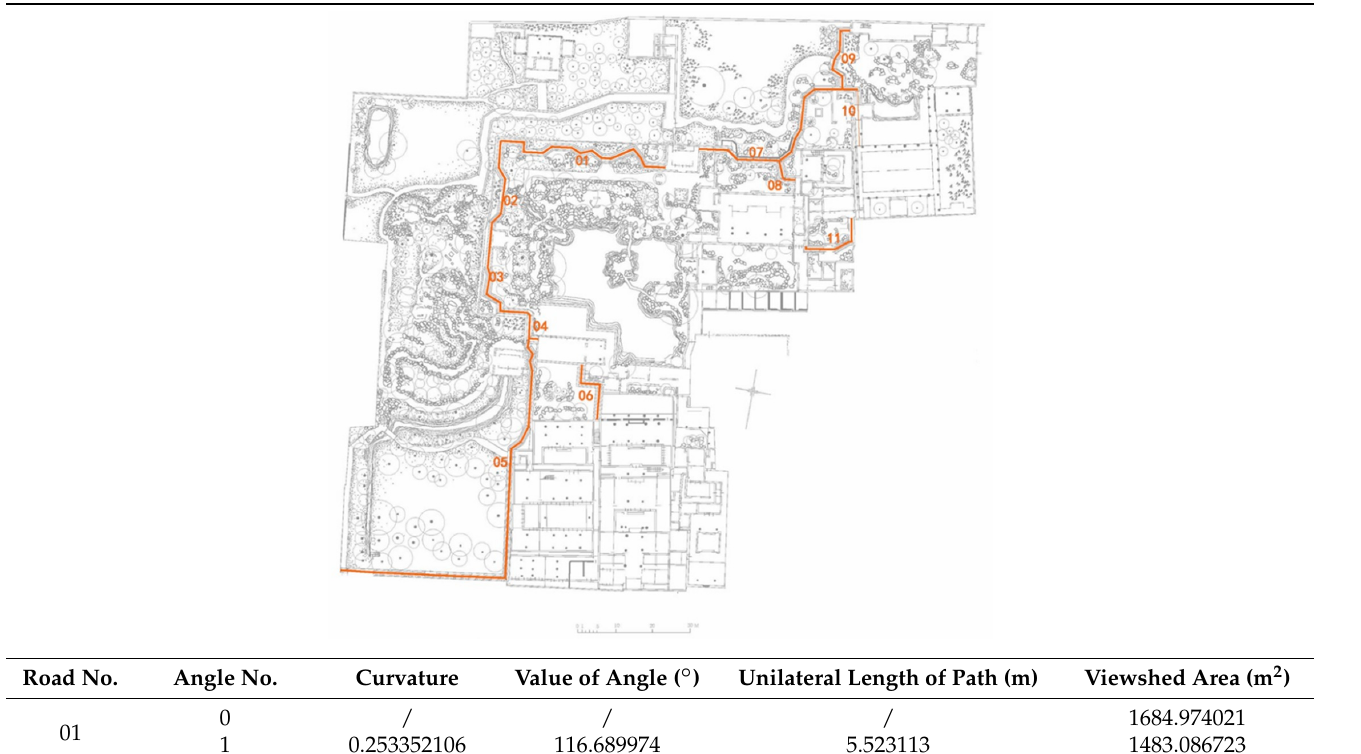
Table A12. Lingering Garden, corridor.